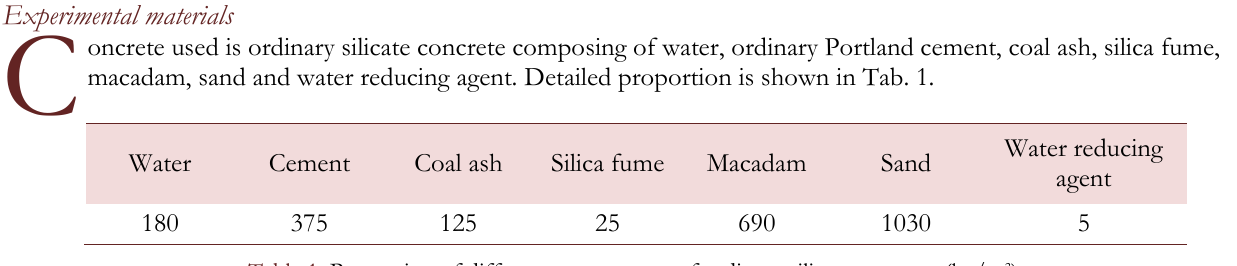
Table 1: Proportion of different components of ordinary silicate concrete (kg/m 3 ).